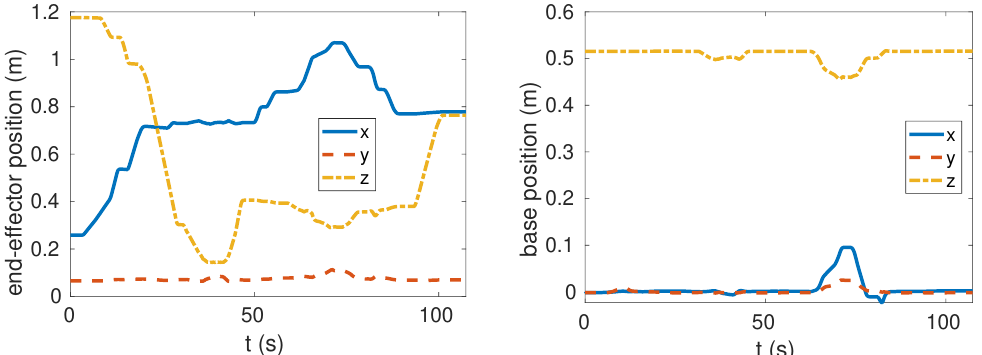
Figure 4. Recorded positions in world frame. The aim is to keep the base still while moving the arm. However, the base shows compliance when the arm reaches its kinematic limits since the base has lower priority in the